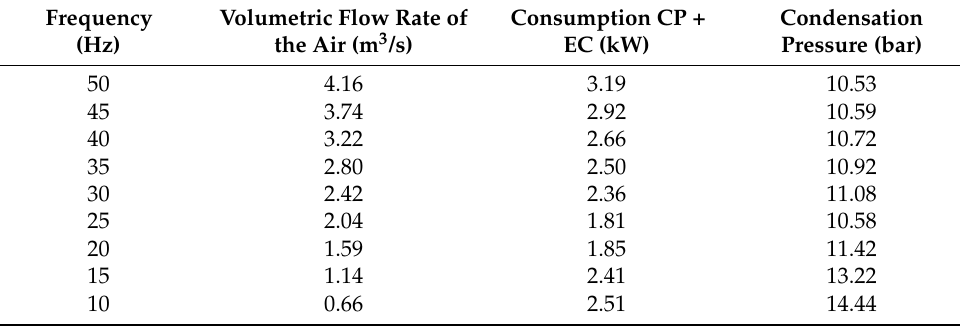
Table 1. Electricity consumption of the experimental